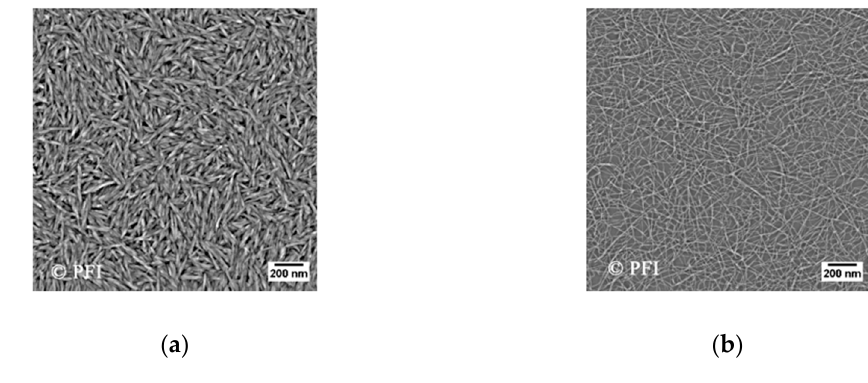
Figure Figure 1. Atomic force microscopy (AFM) images of cellulose nanocrystals ( a ) and 2,2,6,6- tetramethylpiperidine-1-oxyl (TEMPO)-oxidized cellulose nanofibrils ( b ). From the images, it can be seen that both cellulose nanocrystals (CNCs) and TEMPO-oxidized cellulose nanofibrils (T-CNFs) consists of elongated particles, and that T-CNFs are longer compared to the CNCs. They both exhibit anisotropic properties. The procedure for how the AFM images were obtained is explained in Aadland [53] .